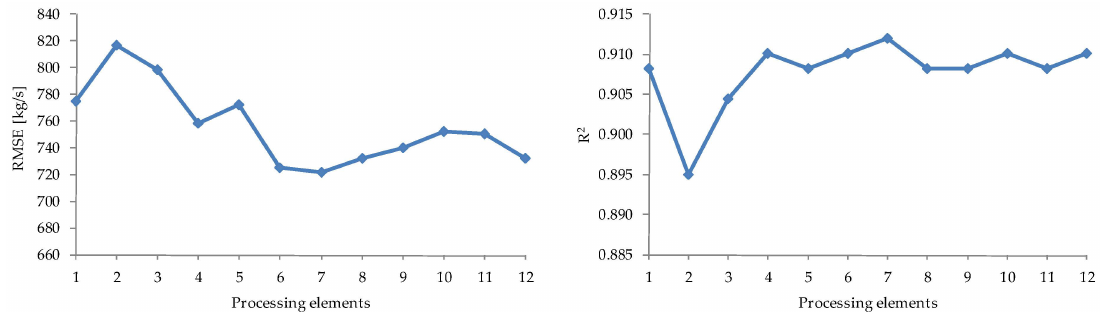
Figure 8. MLP accuracy under a different number of processing